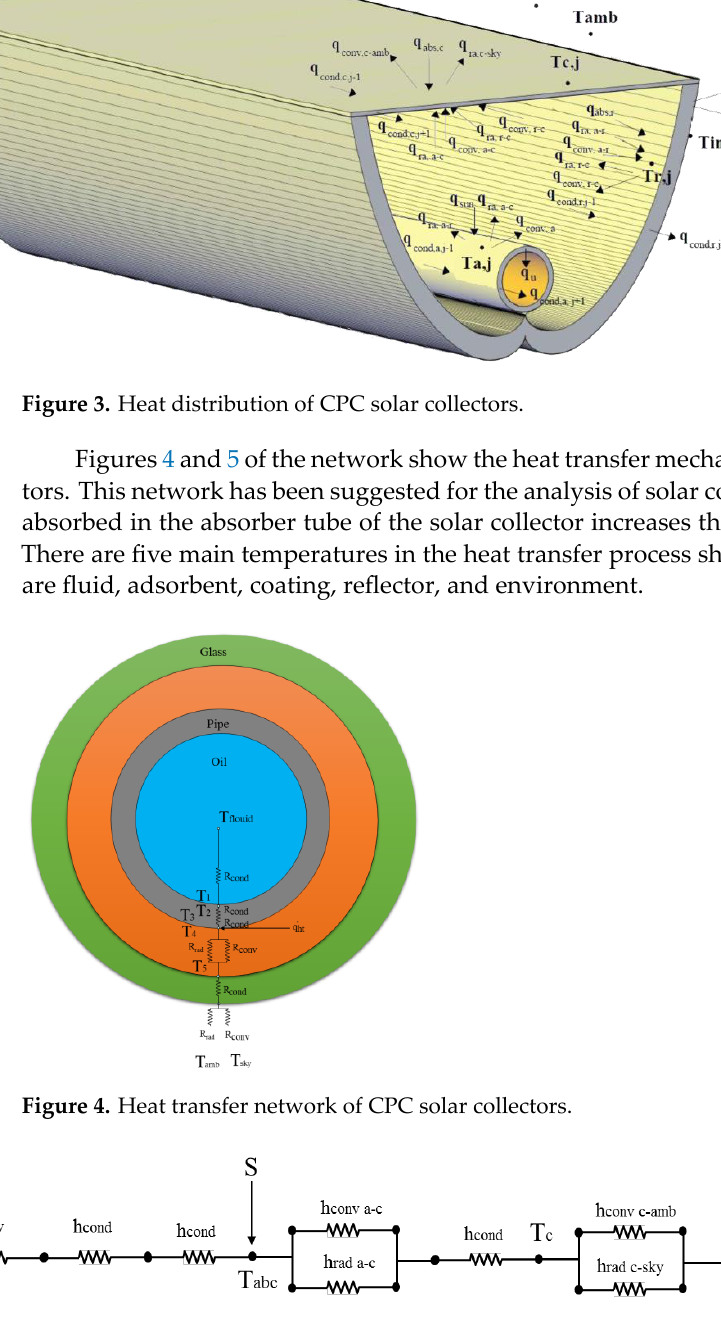
Figure 5. Heat transfer network of CPC solar collectors for mathematical modeling .